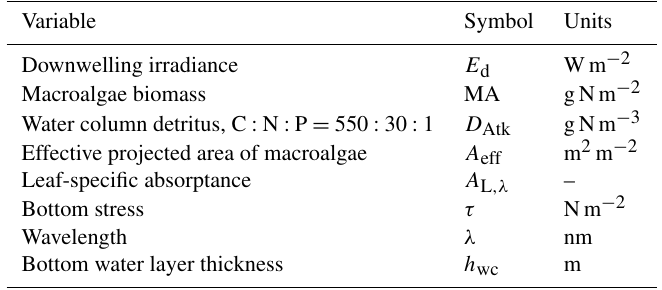
Table 18. State and derived variables for the macroalgae model. For simplicity, in the equations, all dissolved constituents are given in grams, although elsewhere they are shown in milligrams.